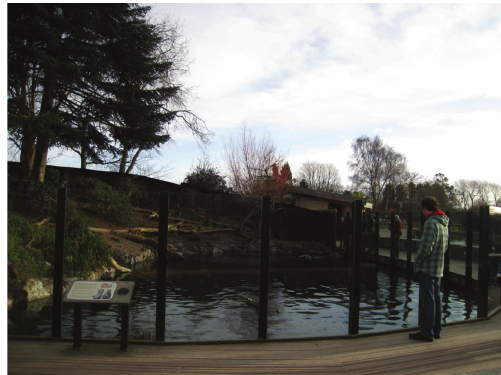
Figure 1: Otter enclosure at Slimbridge, a photograph taken from the front of the enclosure and showing the visitors’